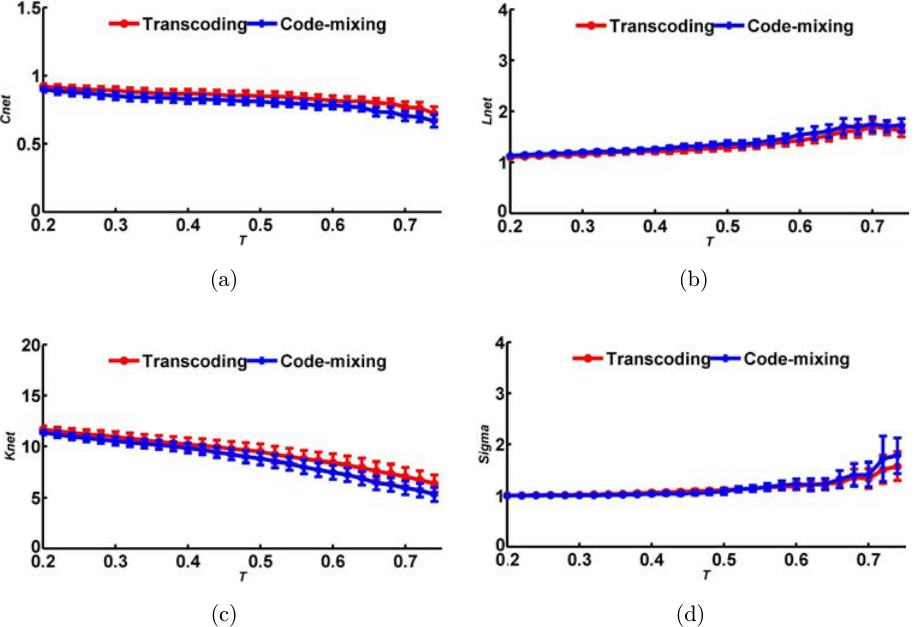
Fig. 4. Comparison of the small-world indicators between the transcoding and code-mixing translation strategies with absolute thresholding: (a) the clustering coe±cient, (b) average path length, (c) average node degree and (d) measure of small-worldness. The curves ð mean (cid:3) SE Þ show the network indicators with di®erent thresholds, in which the red and blue color represent the transcoding and code-mixing strategy respectively. The horizontal axes denote the threshold values whereas the vertical axes denote the network property indexes.